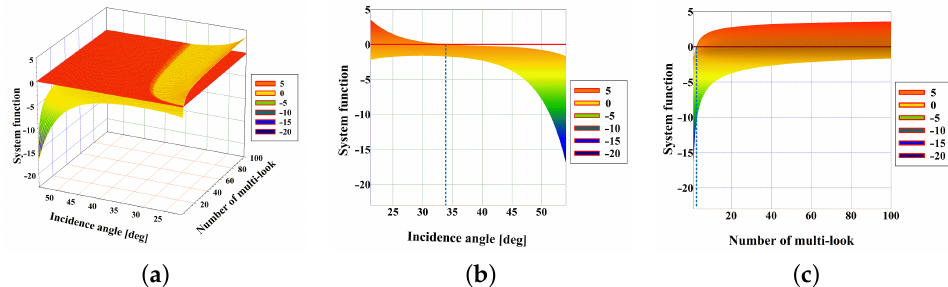
Figure 7. ( a ) The SAR system function varies with the incidence angle φ and the number of multi- looks L look when the average transmitting power, satellite height, and scale factor of water ice are P av = 100,000 W, H sat = 100 km and 5%. ( b , c ) are the simulation results of the system function changing with φ and L look ,